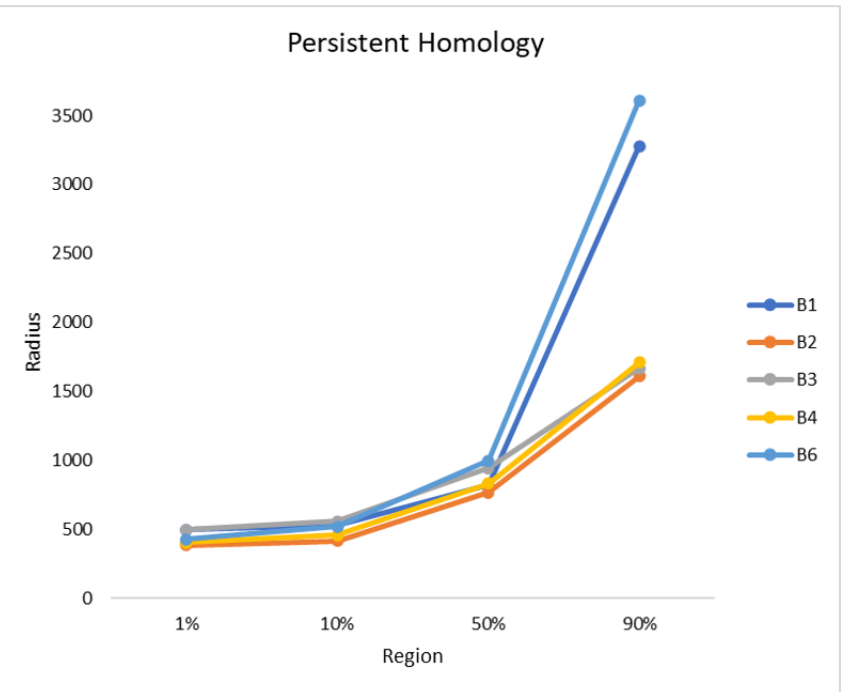
Figure 7. The persistent homology is plotted by radius against the region. Four fused regions were considered: 1%, 10%, 50%, and 90% and all sites are